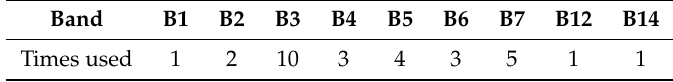
Table 8. The number of times WorldView-3 bands were used with the hierarchical approach for tree mapping.